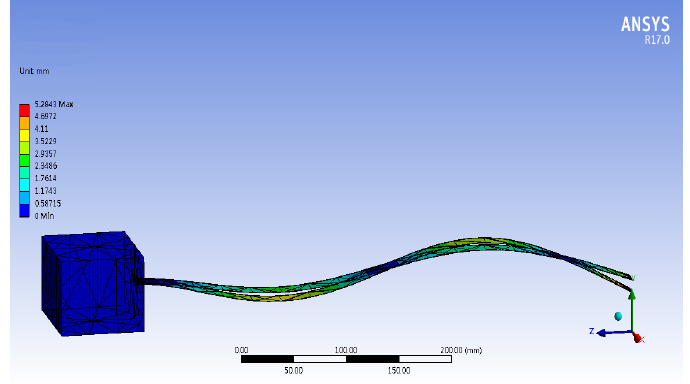
Figure 4. DESS 3rd modevibration mode.